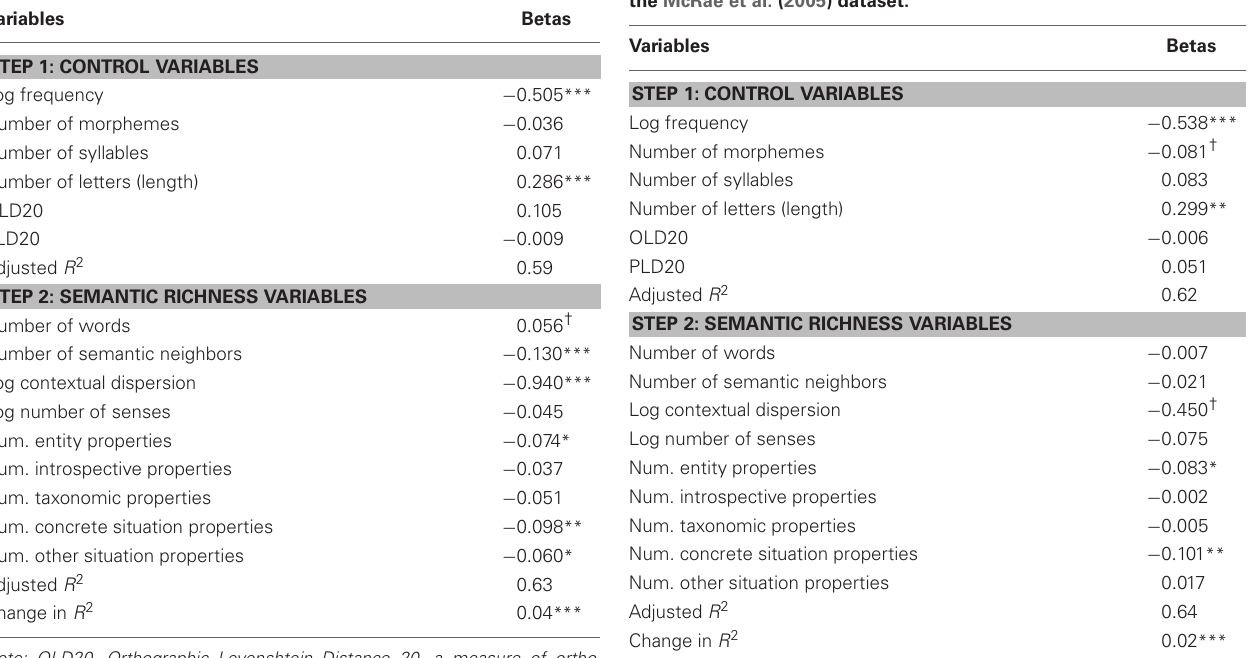
Table 6 | Standardized regression coefficients predicting lexical decision latencies, using feature counts and codes from data collected in Analysis 1.